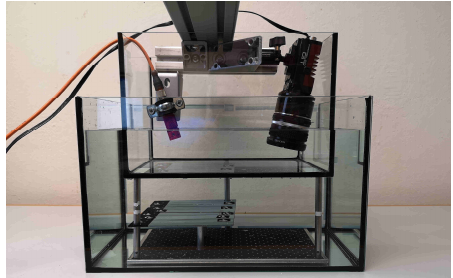
Figure 6: Set-up of the experiment, before camera and laser orientation were adjusted.